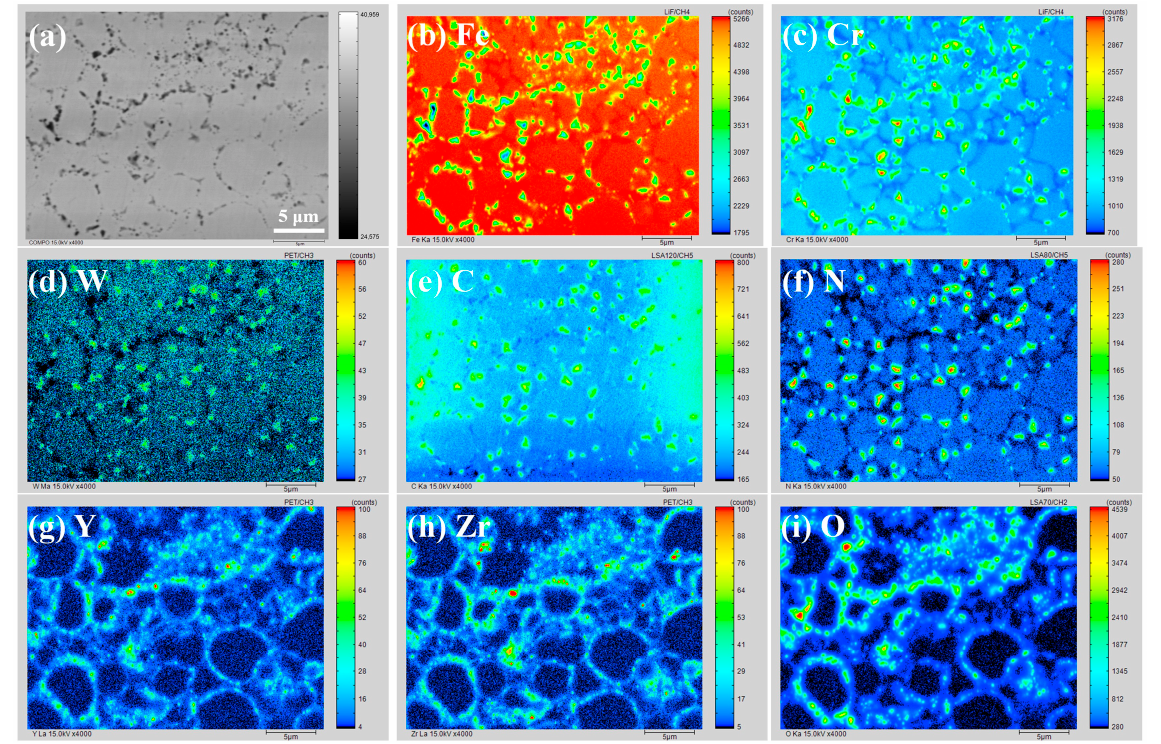
Figure 14. Morphology and corresponding EPMA mapping results of a typical area in specimen A4: ( a ) Morphology, ( b – i ) EPMA mapping results.